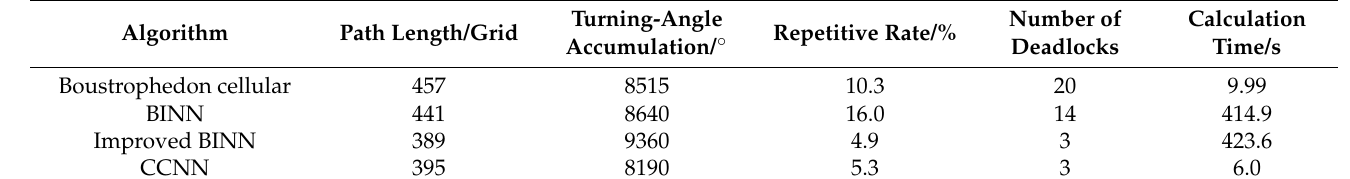
Table 3. Simulation results of different algorithms in artificial environment.